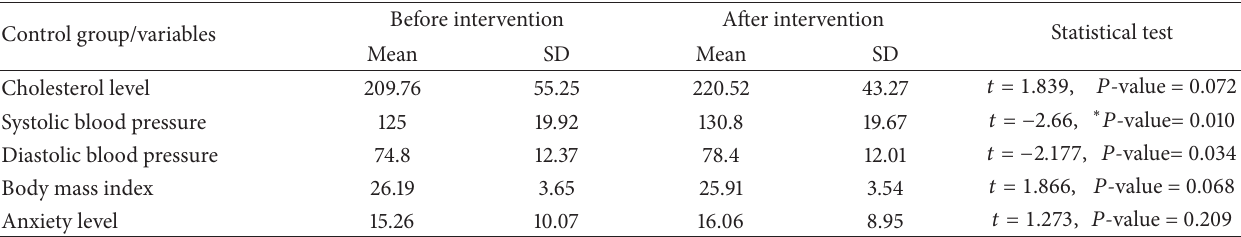
Table 3: Comparison of average and criterion deviation of anxiety level, body mass index, cholesterol level, and blood pressure in the patients with infarction before and after intervention in the control group 2011.